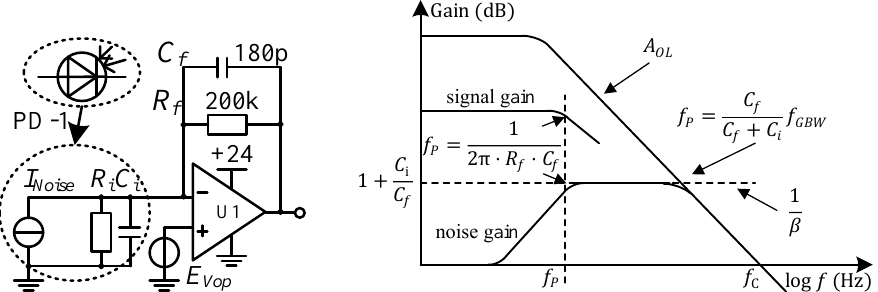
Figure 2. The equivalent noise model of the preamplifier ( left ) and the gain–frequency characteristics of noise gain and signal gain ( right